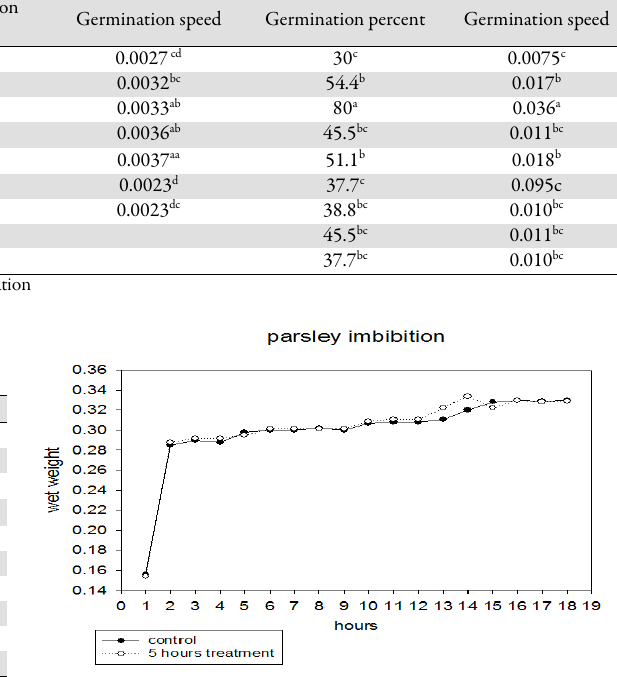
Fig. 2. Imbibition curve of control and the highest significant treatment of parsley seeds